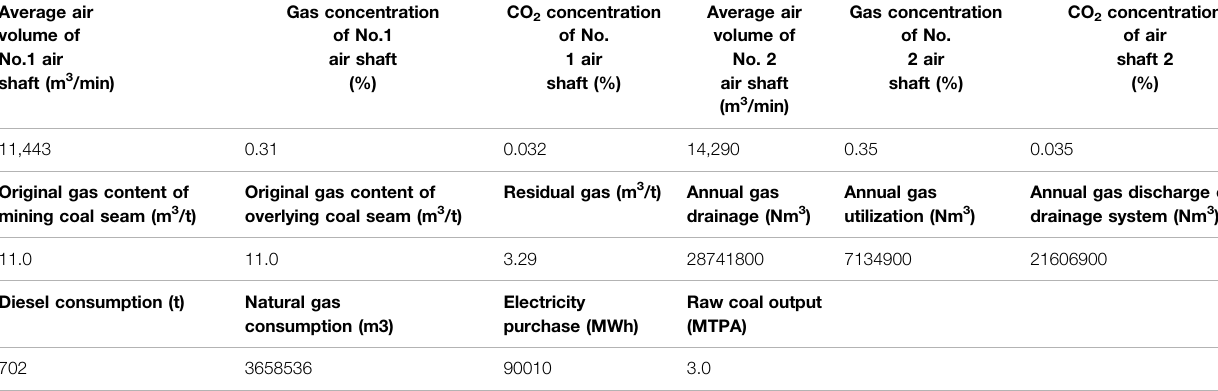
TABLE 4 | Data of carbon emission of Wangpo coal mine in 2020.